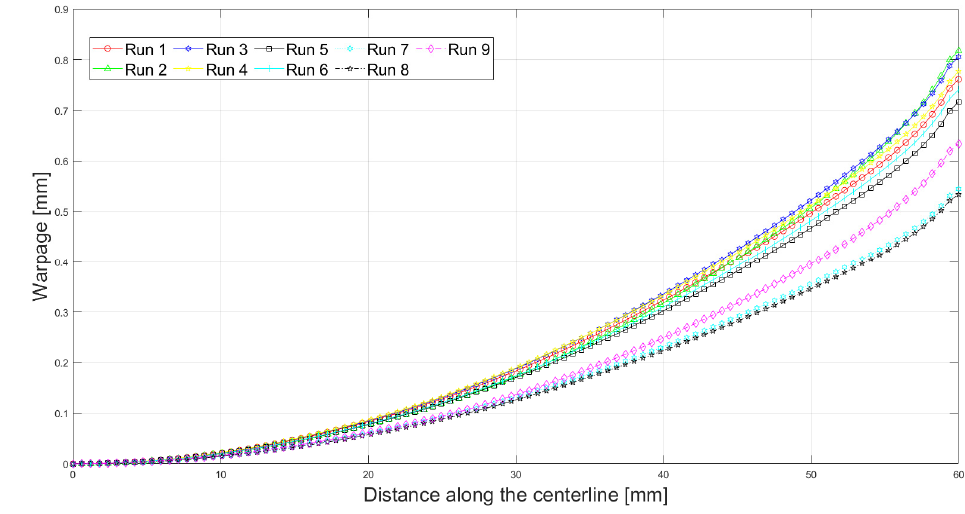
Figure 8. Warpage along the central half-length.